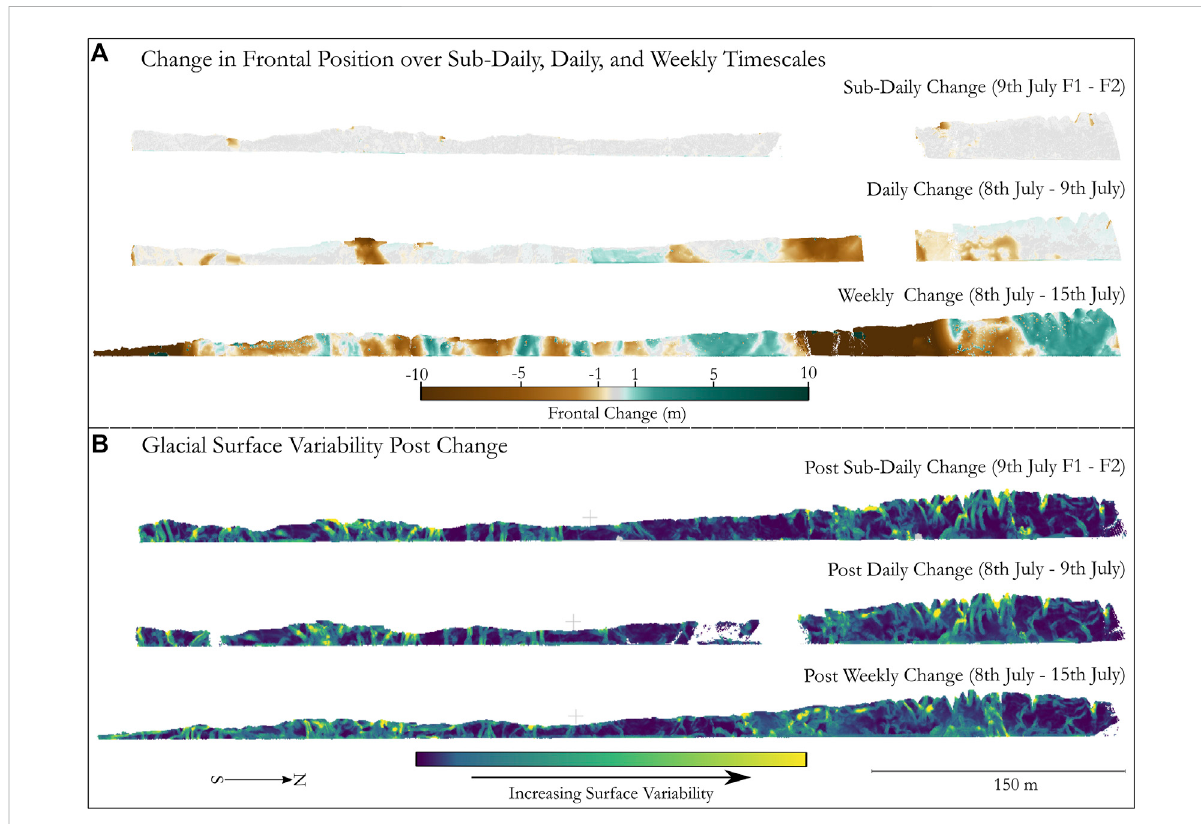
FIGURE 8 (A) Changesinthepositionofthecalvingfrontforthethreetimeperiodsofinterest.Thebrown,grey,andblueregionsrepresentcalvingevents, change less than the level of detection from thesetup for those two surveys, and regions of terminus advance, respectively. Gaps in thedata aredue toaninsuf fi cientdensityofdatapointstoaccuratelyinterpolatethecalvingfront. (B) Changesincalvingfrontgeometryacrossthethreetimeperiods of interest. Geometries are representative of the surface variation at the end of each time period shown. Values in yellow indicate a higher degree of surface variation, and as such a less planar surface, with darker blues indicating a smoother, fl atter surface. Areas where the point density was too low to obtain an accurate representation of the surface have been removed. Surface variability is given without scale here, and is based on a comparison of the eigenvalues obtained from a PCA of the geometry of a cloud surrounding an individual point (see Hackel et al.,